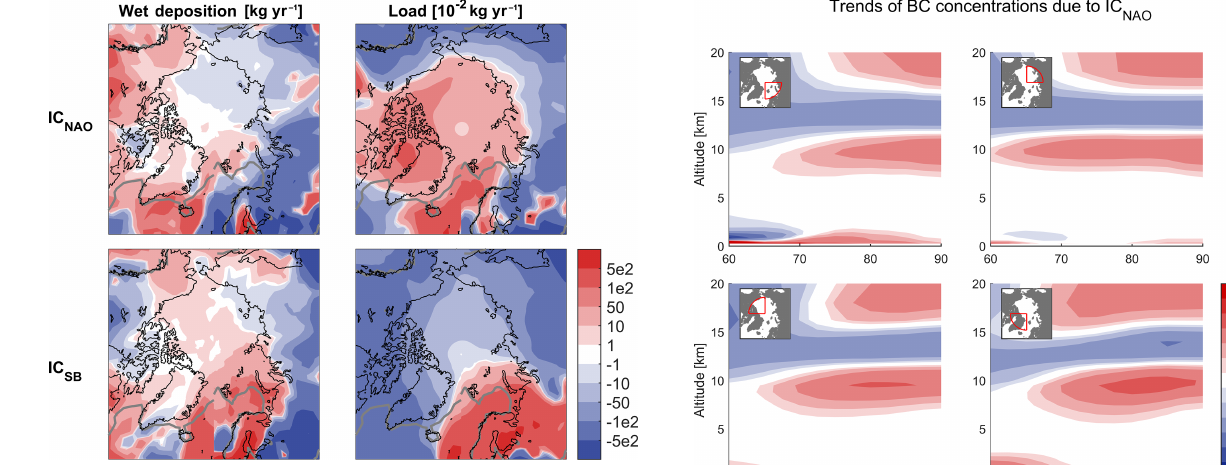
Figure 4. Winter (DJF) trends (1980–2015) of maximum likeli- hood estimates (MLEs) of BC wet deposition (kgyr − 1 ) and load (kg × 10 − 2 yr − 1 ) associated with IC NAO and IC SB . The grey line represents the mean winter sea ice and snow cover larger than 50% from 1980 to now. NAO and SB trends are both significant at 5% level.